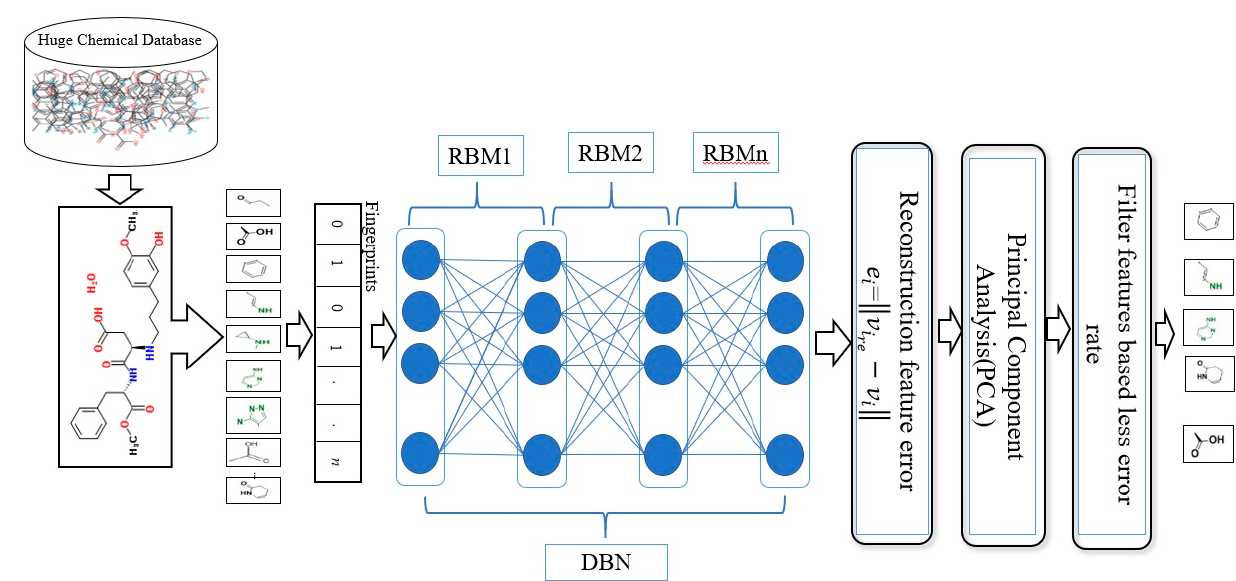
Figure 4. Reconstruction of features weight steps.